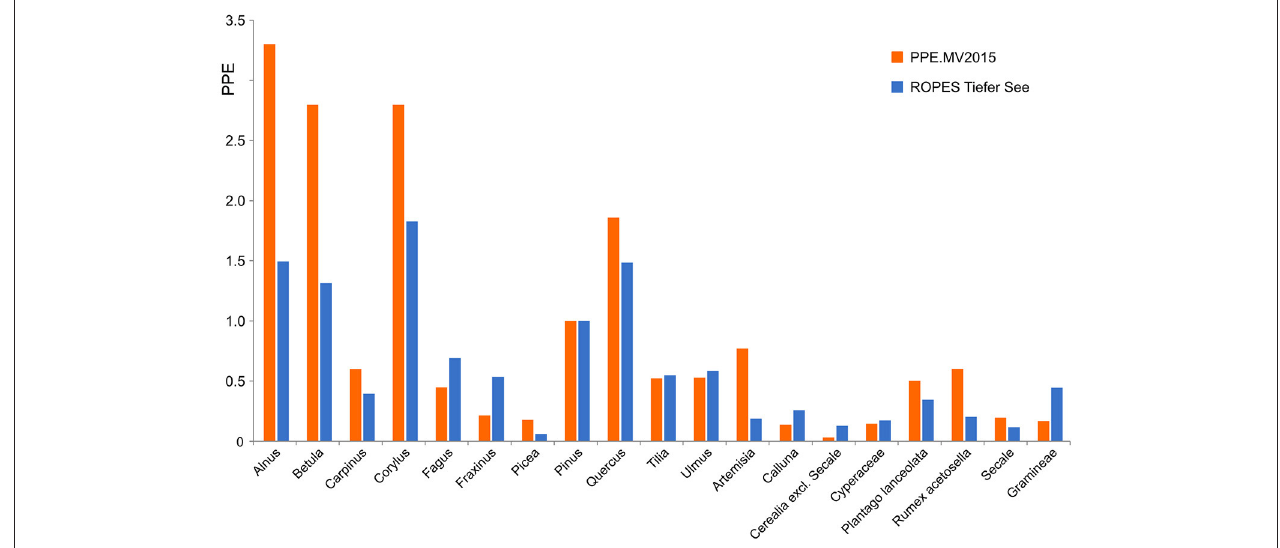
FIGURE 6 | PPEs produced with ROPES from the Lake Tiefer See record (TSK, 250 samples) compared with the PPE.MV 2015 set of PPEs from Theuerkauf et al.